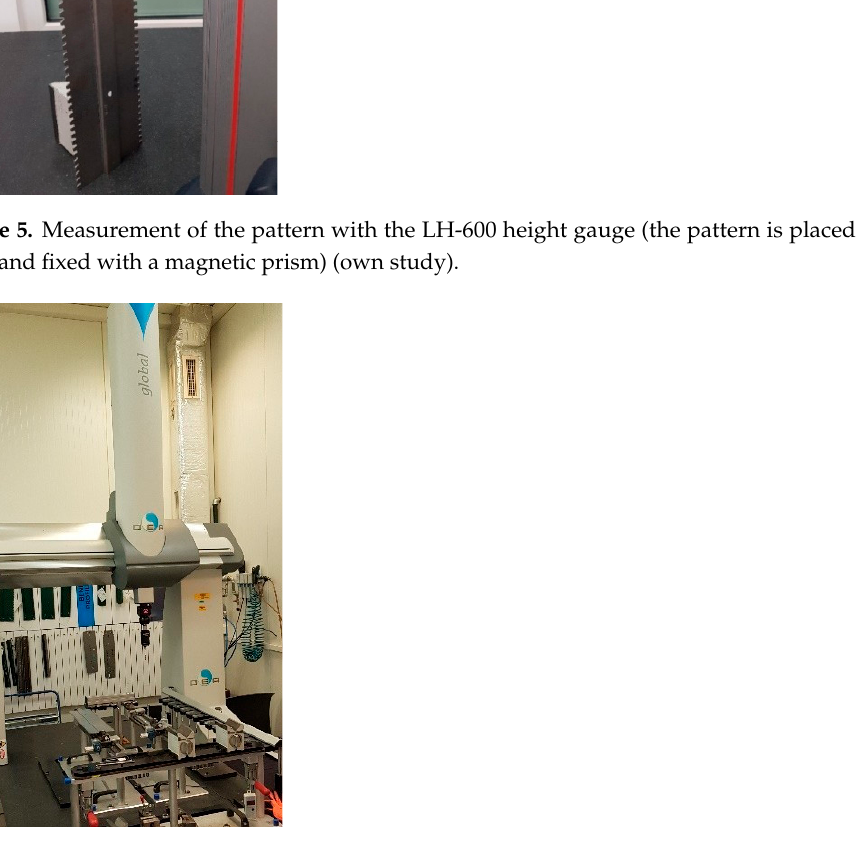
Figure 5. Measurement of the pattern with the LH-600 height gauge (the pattern is placed on the plate and fixed with a magnetic prism) (own study).